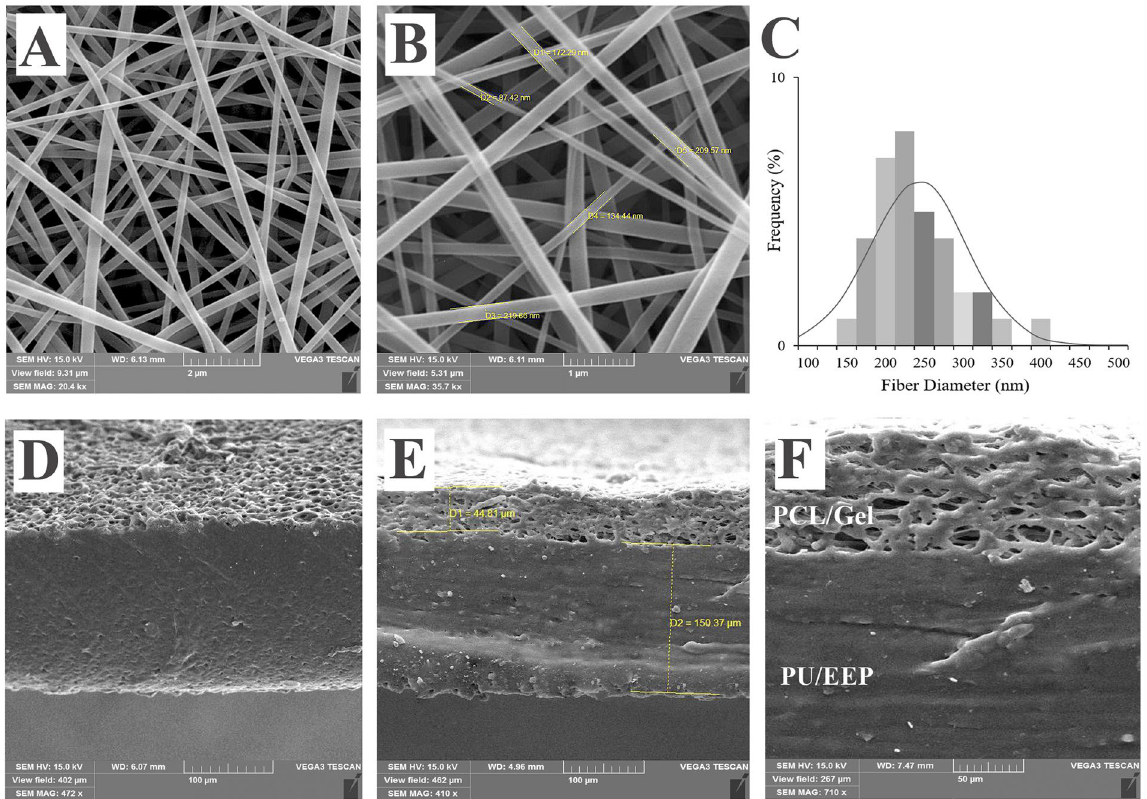
Figure 4. SEM micrographs of the PCL/Gel nanofibers with ( A ) 20400 X and ( B ) 35700 X magnifications. ( C ) The fibers’ diameter distribution chart. The cross-sections of the ( D ) PU/EEP and PU/EEP-PCL/Gel bilayer wound dressing with ( E ) 410X and ( F ) 710 X